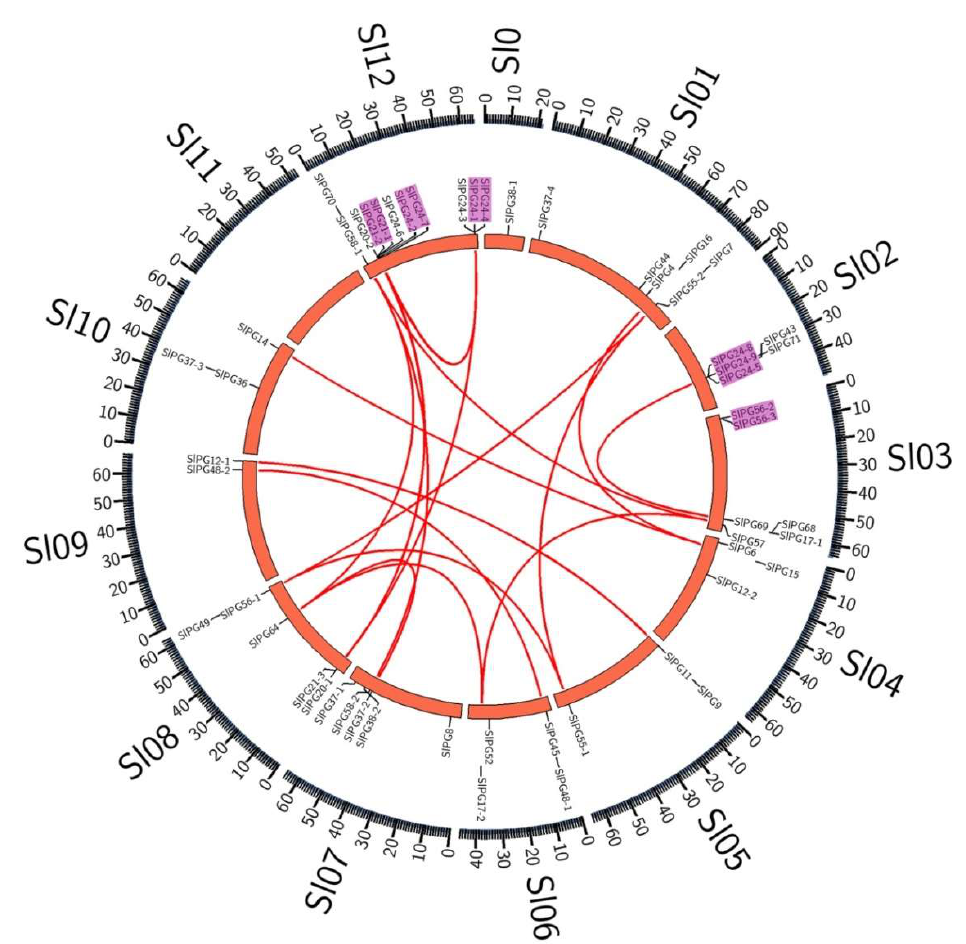
Figure 2. Genomic distribution and syntenic analysis of PG genes in S. lycopersicum generated by CoGe comparative genomics system [31] and Circos [32]. The red lines represent syntenic relationships of the paralogous SlPG genes. The chromosome numbers are demonstrated next to each chromosome. Tandem-duplicated genes are indicated by the pink rectangles.